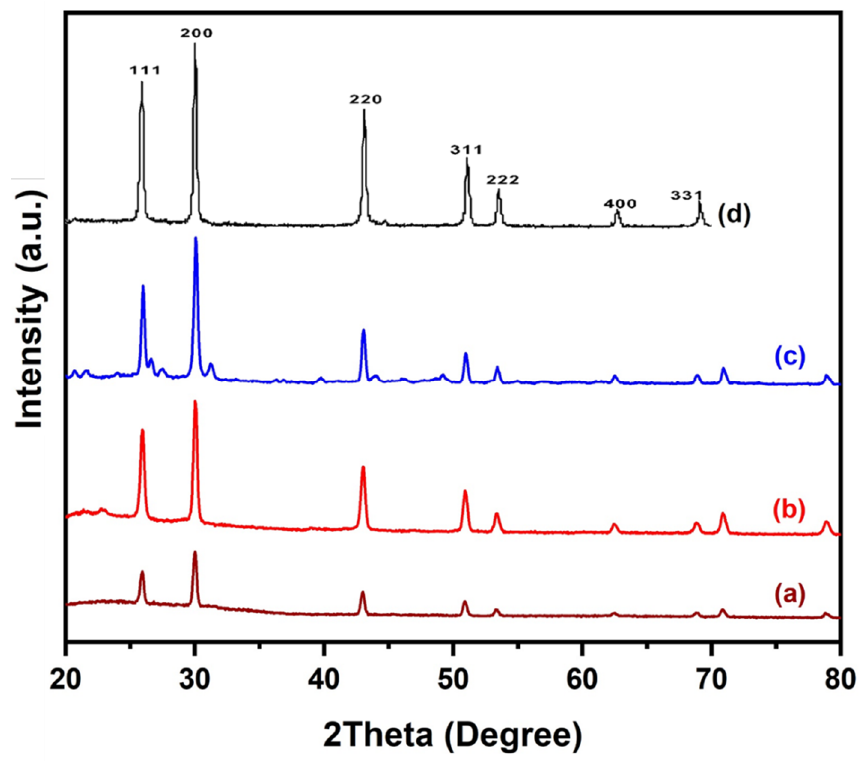
Figure 3. XRD pattern of as-deposited PbS at: ( a ) 400 °C; ( b ) 450 °C; ( c ) 500 °C; ( d ) Reference pattern of PbS [23,24] .